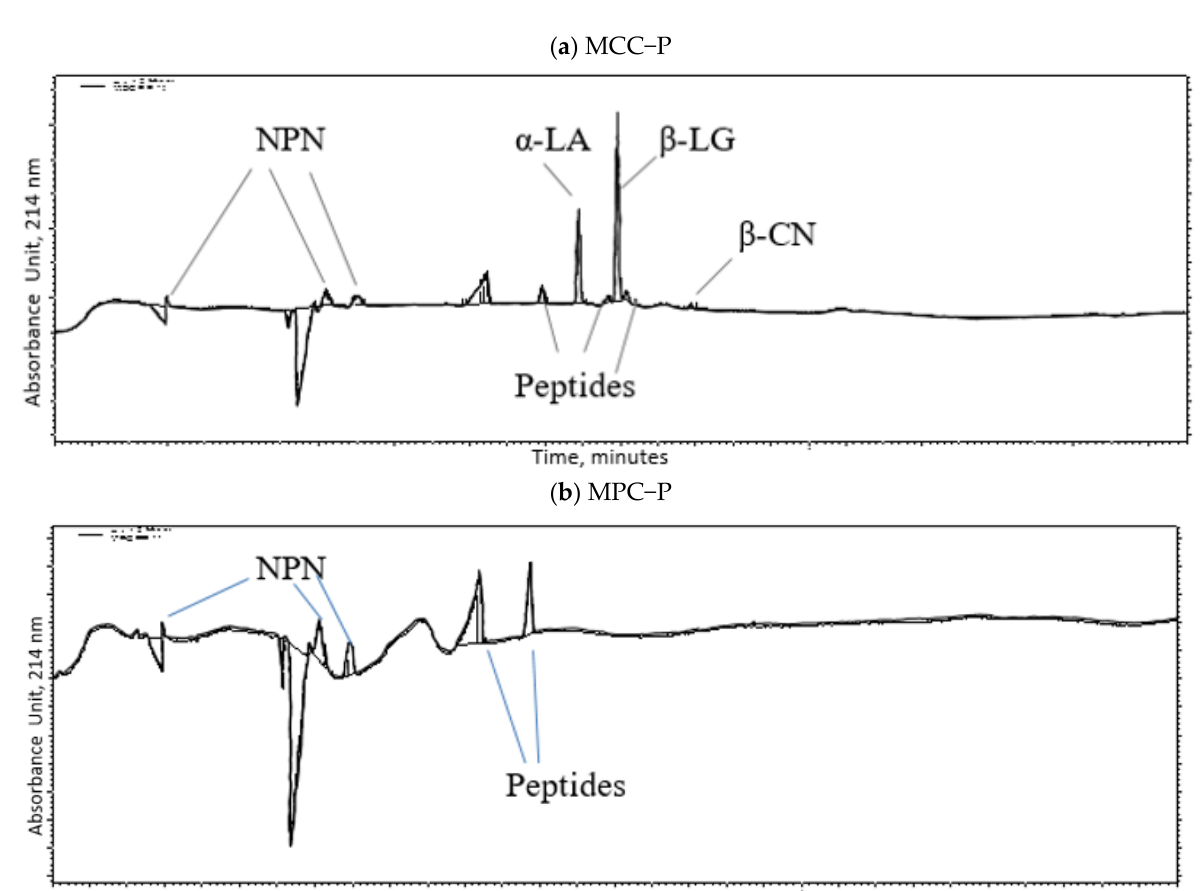
Figure 5. Capillary gel electrophoreogram of ( a ) MCC−P = micellar casein concentrate permeate; ( b ) MPC−P = milk protein concentrate permeate; NPN = non protein nitrogen.